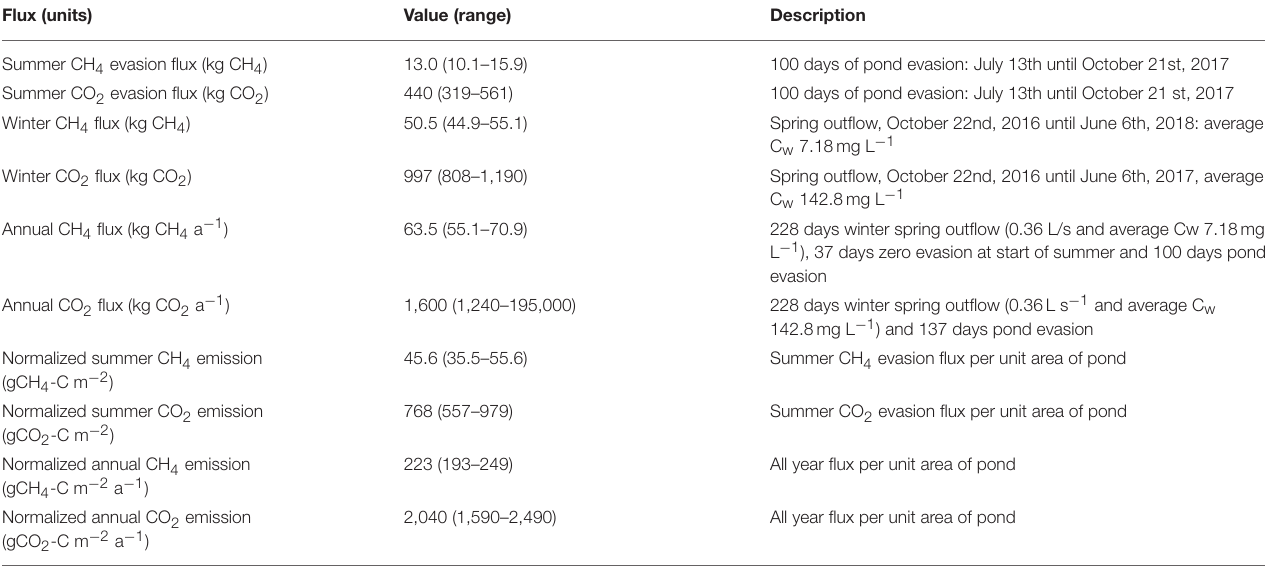
TABLE 2 | Fluxes of CH 4 and CO 2 estimated by the study and including the summer emissions from the pond and the winter emissions from the